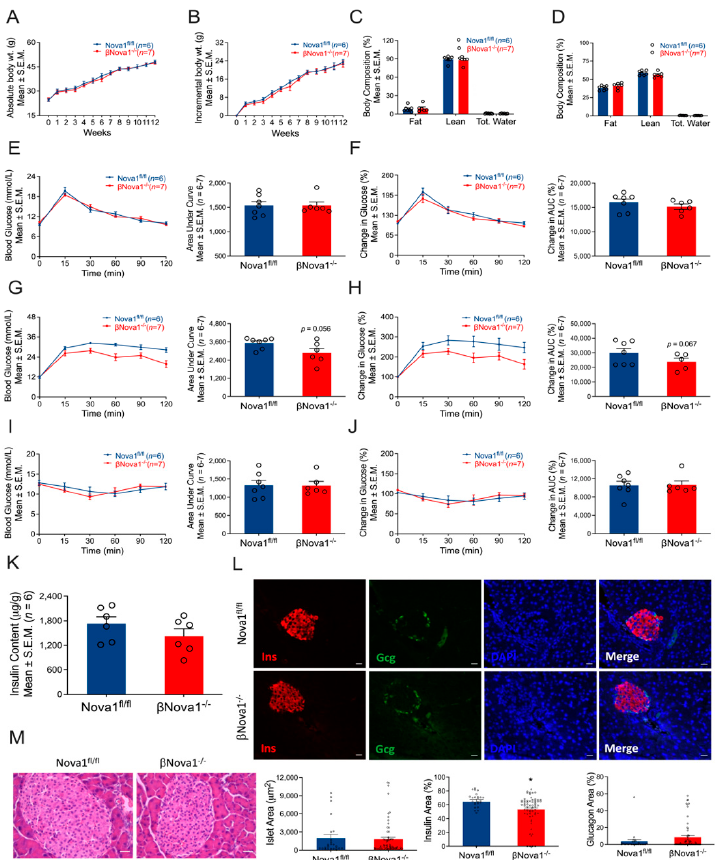
Figure 2. Effect of high-fat diet on glucose homeostasis of β Nova1 − / − mice. β Nova1 − / − mice were fed a high-fat diet for 12 weeks. Body weight was measured weekly ( A , B ). Incremental body weight ( B ) was calculated as cumulative gain in body weight (g) every week. Body composition (fat mass, lean mass, and total water) was measured before and after 12 weeks of high-fat diet feeding ( C , D ). A glucose tolerance test performed before high-fat diet feeding did not show any change in β Nova1 − / − mice compared to Nova1 fl/fl mice ( E , F ). After 12 weeks following the high-fat diet, β Nova1 − / − mice exhibited a trend towards improved glucose tolerance compared to Nova1 fl/fl mice ( G , H ). However, an insulin tolerance test measured one week after the IPGTT did not show any difference between the two genotypes ( I , J ). Pancreatic insulin content was measured in an acid–ethanol extracted fraction using a commercial ELISA kit ( K ). Immunofluorescence staining of pancreatic sections (insulin, glucagon, and DNA) from both high-fat-fed and control Nova1 fl/fl and β Nova1 − / − mice ( L ). Insulin (red staining) is contained in the core zone of the islet, while glucagon (green staining) is found in the mantle zone. Scale bar, 20 µ m. Representative of 3 mice per genotype ( L ). Bottom panel ( L ) showing islet area, insulin, and glucagon positive cells (calculated as % of total islet area). Histology of mouse pancreas stained by Hematoxylin and Eosin ( M ). Scale bar, 25 µ m. Data are presented as Mean ± SEM. * p < 0.05 vs. Nova1 fl/fl